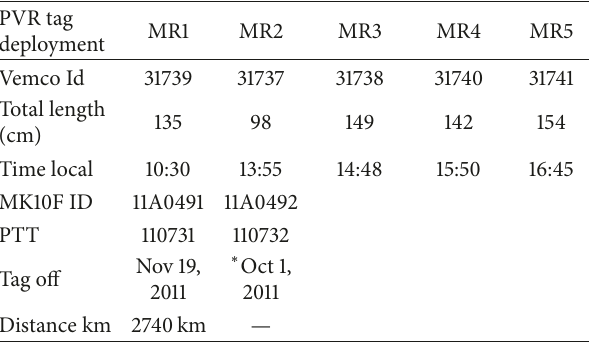
Table 1: Summary for tags deployed on Sep 26,